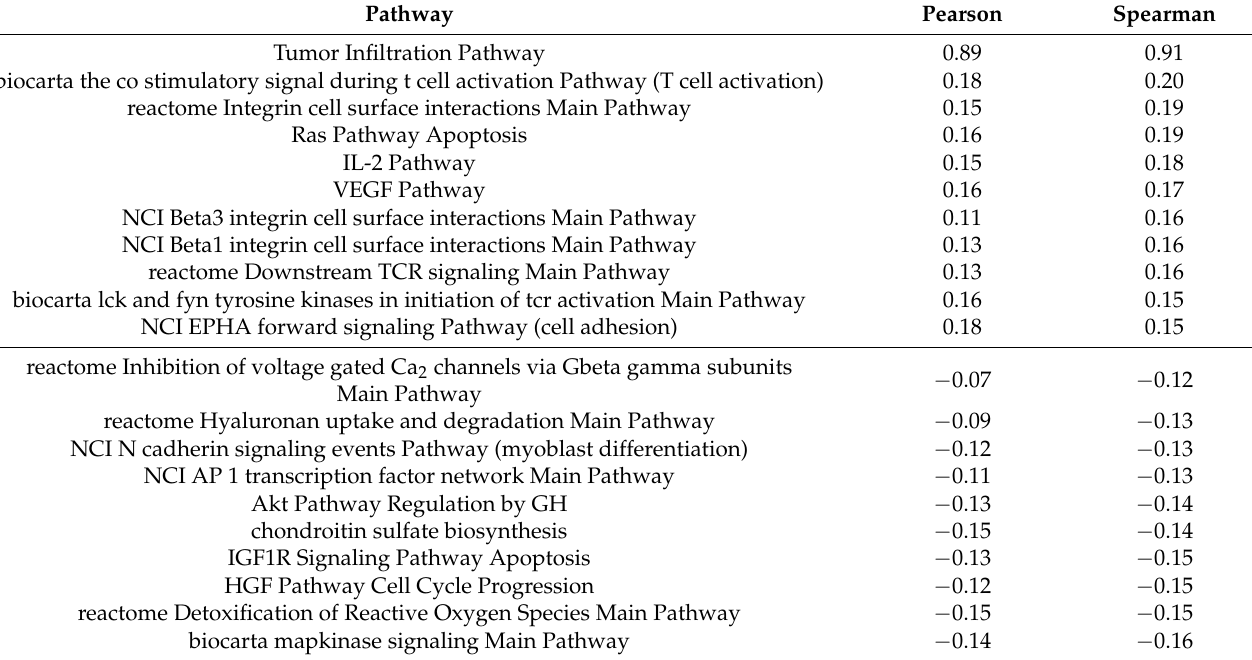
Table 3. “Top-10” of the most and the least correlated molecular pathways between RNA and protein expression data calculated for Hepatocellular Carcinoma biosamples.